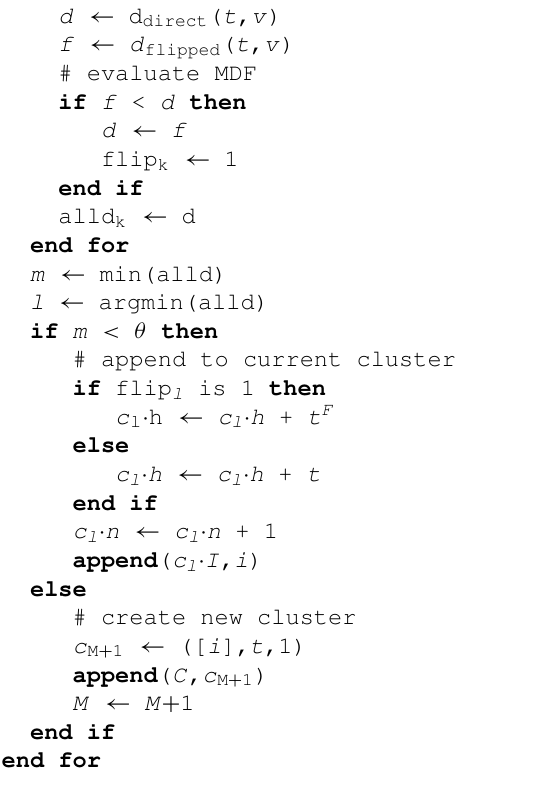
Algorithm 1. One of the reasons why QB has on average